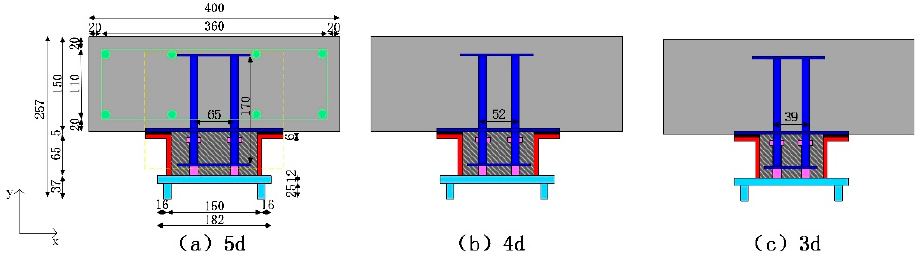
Figure 27. Spacing arrangement of shear reinforcement and studs.